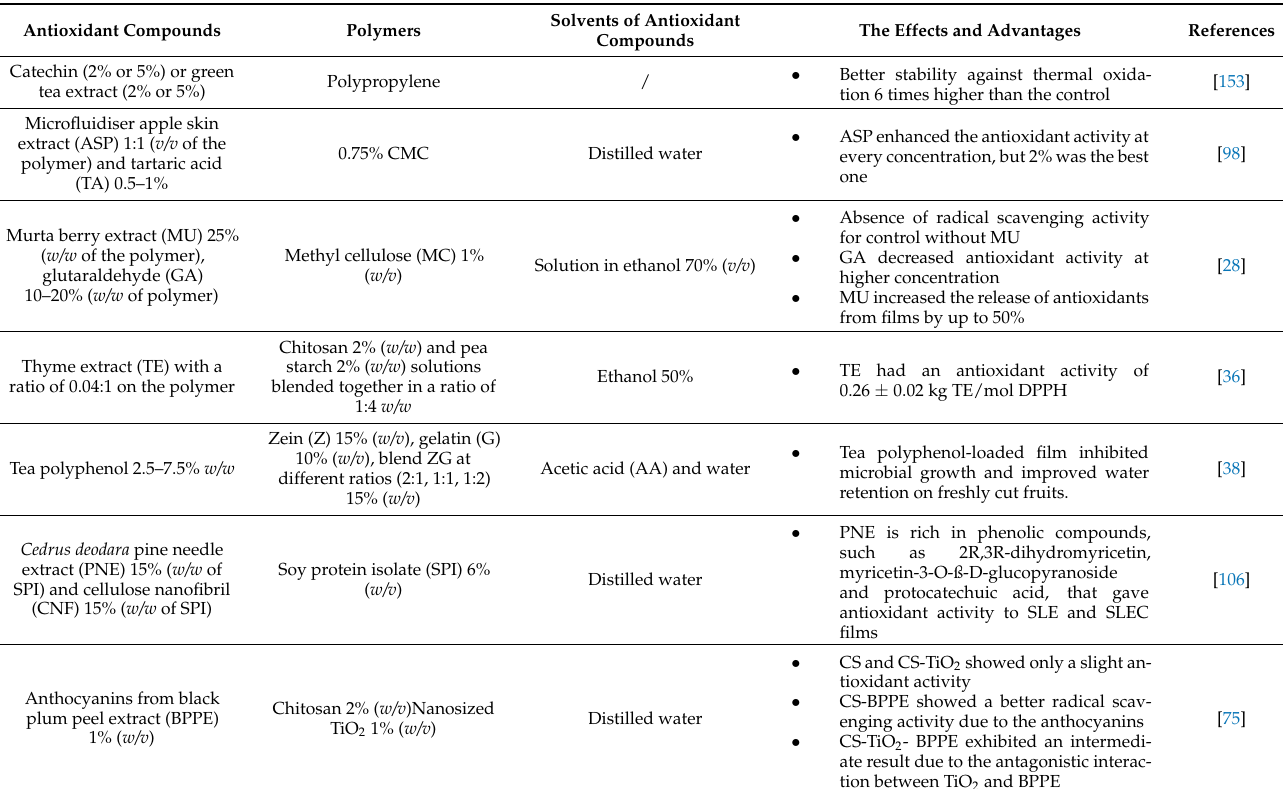
Table 4. Case studies of antioxidant compounds applied to food packaging for the prolongation of the